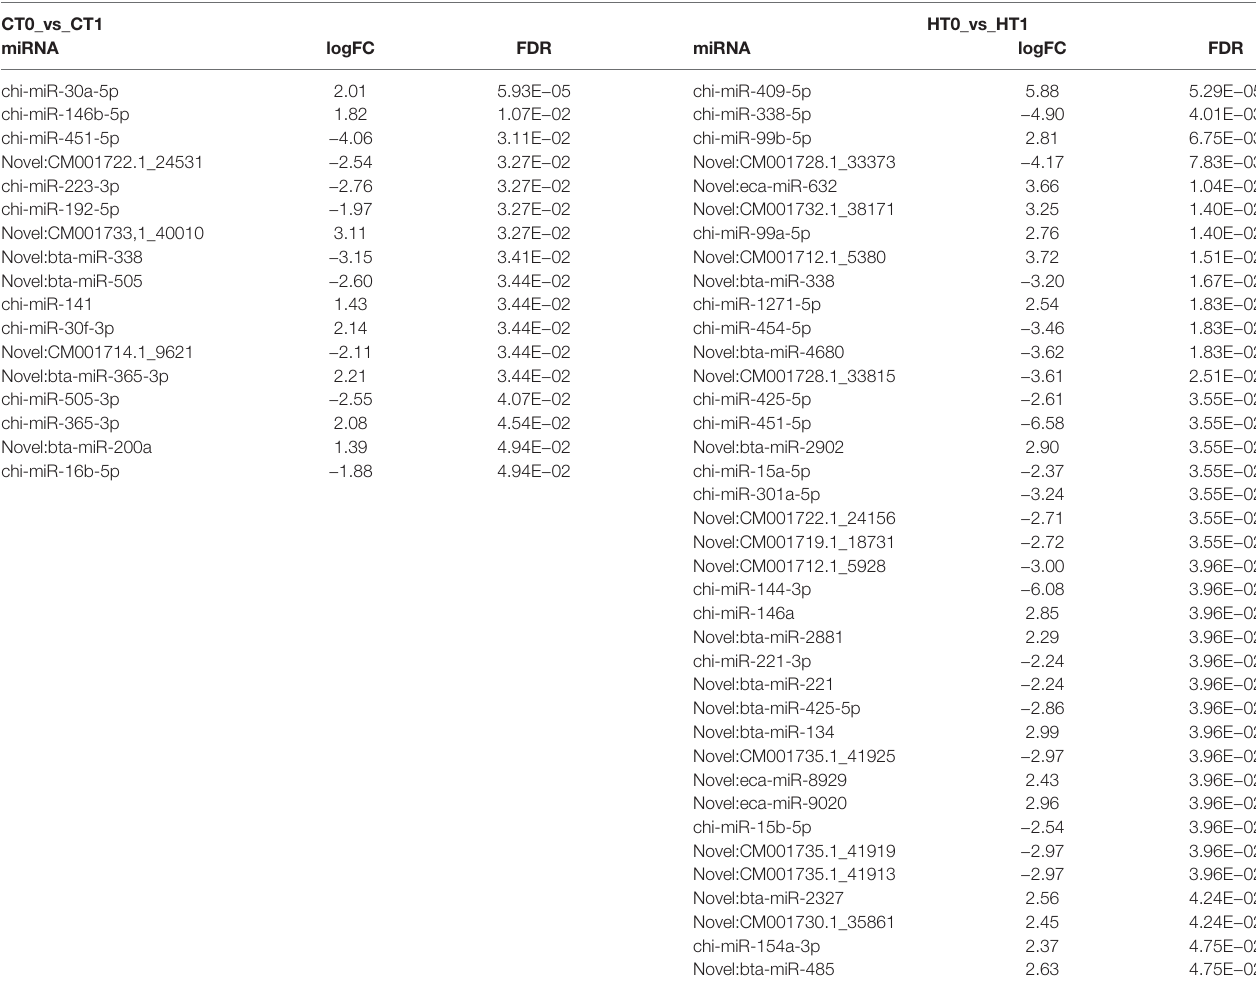
TABLE 3 | Differentially expressed miRNAs (DE-miRNAs) in milk somatic cells (MSCs) from animals given the hemp (H) and control (C) diets in the two time points (T0 and